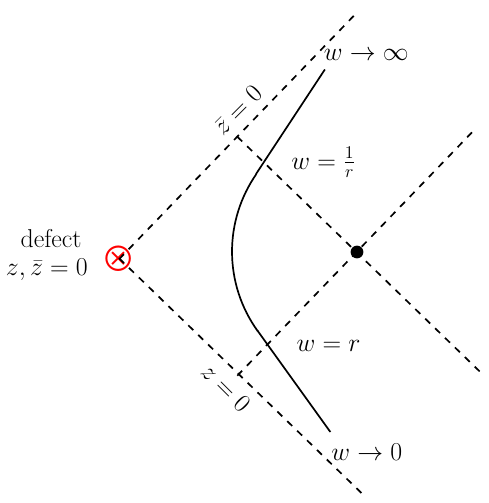
Figure 2 . The positive real axis on the w complex plane, at (cid:12)xed r < 1, maps to the black solid line in the ( z; (cid:22) z ) plane. The bulk OPE singularities correspond to the intersection of the line with the past and future lightcones of the operator (cid:30) (1 ;